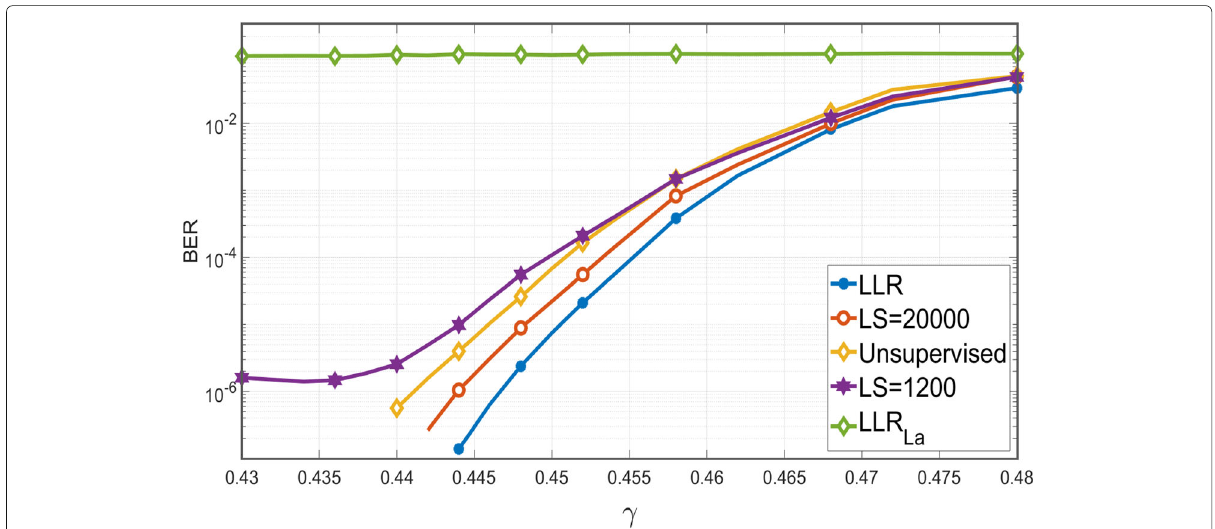
Fig. 8 BER comparison in highly impulsive S α S noise. Evolution comparison of the BER as a function of the dispersion γ of a S α S noise in highly impulsive environment with α = 1.4, between the supervised with different learning sequence sizes, unsupervised, Gaussian designed